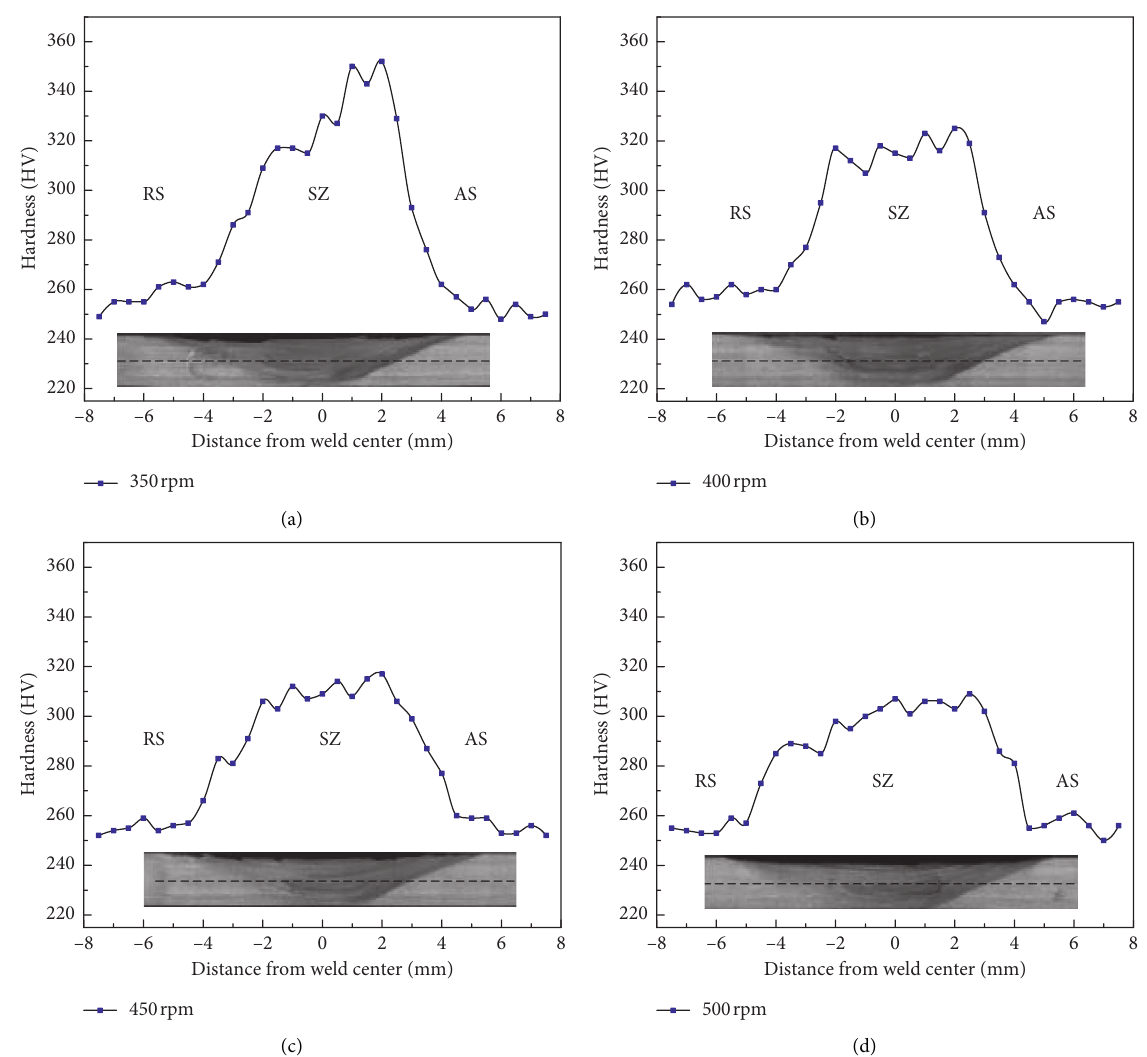
Figure 13: Typical hardness profile of the joints welded at different rotation